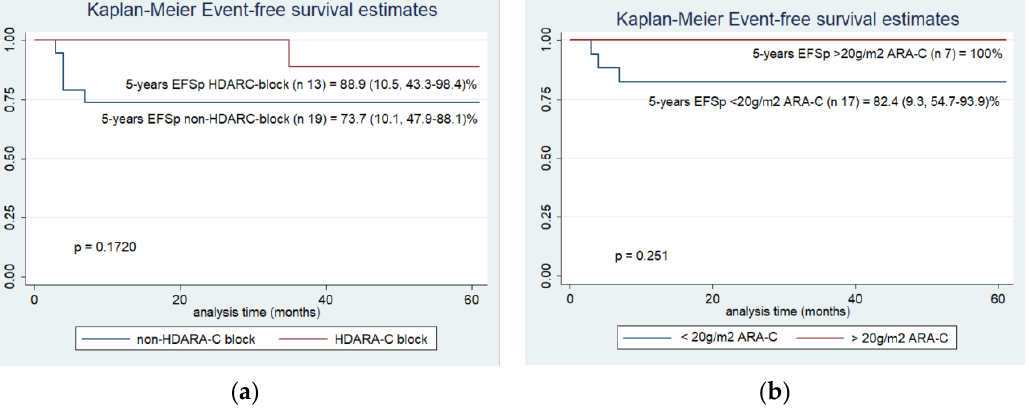
Figure 4. 5-years EFSp for classical ML-DS (n31) who achieved CR, according cytarabine treatment dosis. ( a ) 5-years EFSp for classical ML-DS according HDARA-C block, ( b ) 5-years EFSp for classical ML-DS according receiving > or <20 g/m 2 cytarabine.